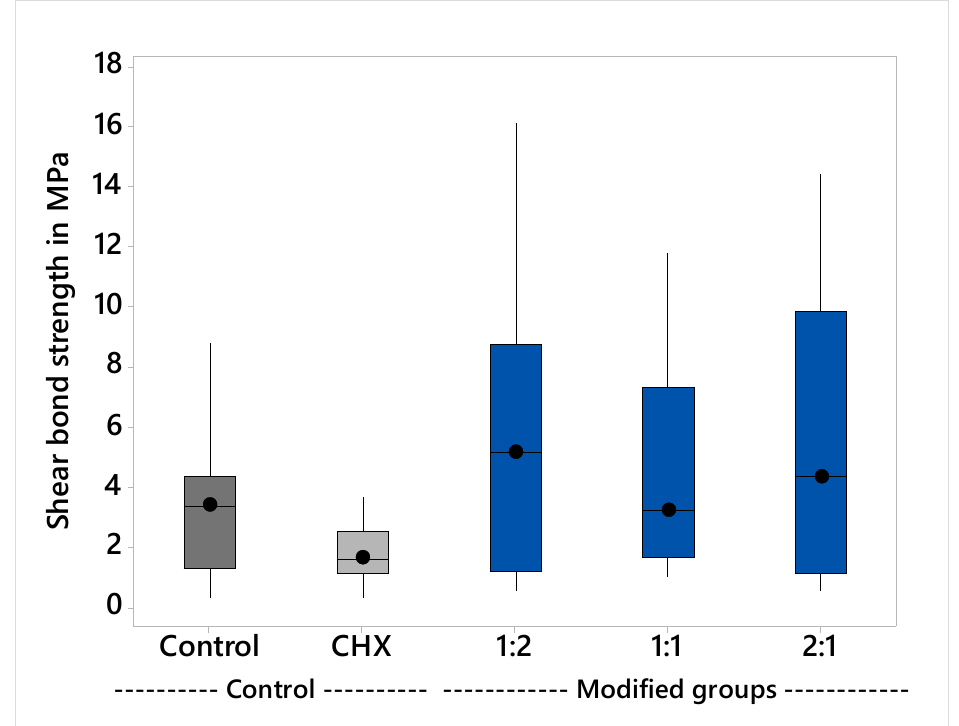
Figure 1. Median shear bond strength and interquartile range. Failure